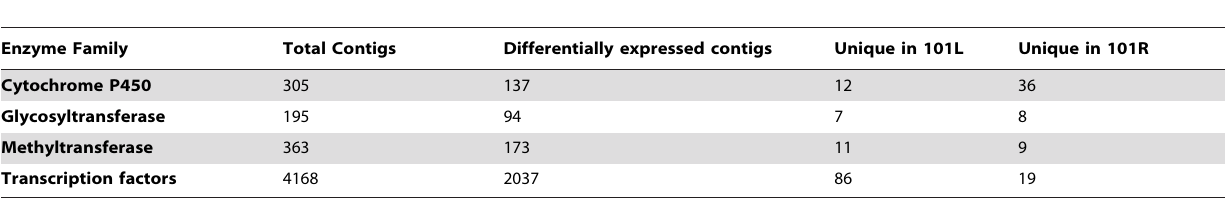
Table 5. Contigs encoding various gene families annotated against different databases.